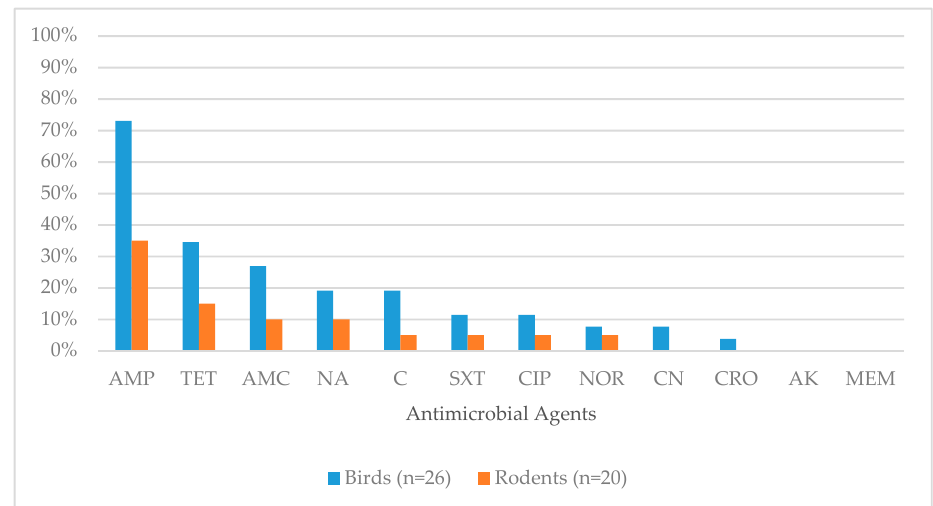
Table 3. Percentage of E. coli isolates from wild birds and rodents resistant to at least one antimicrobial.